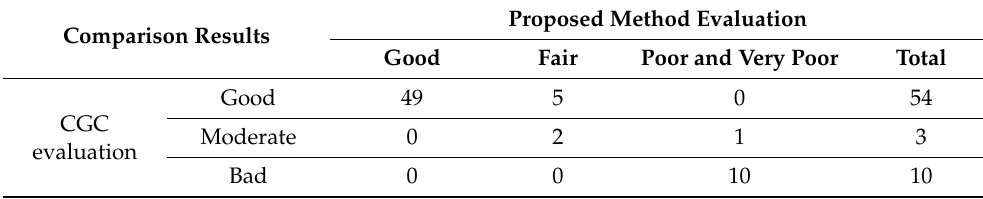
Table 5. Comparison result produced by the proposed method and CGC. Comparison